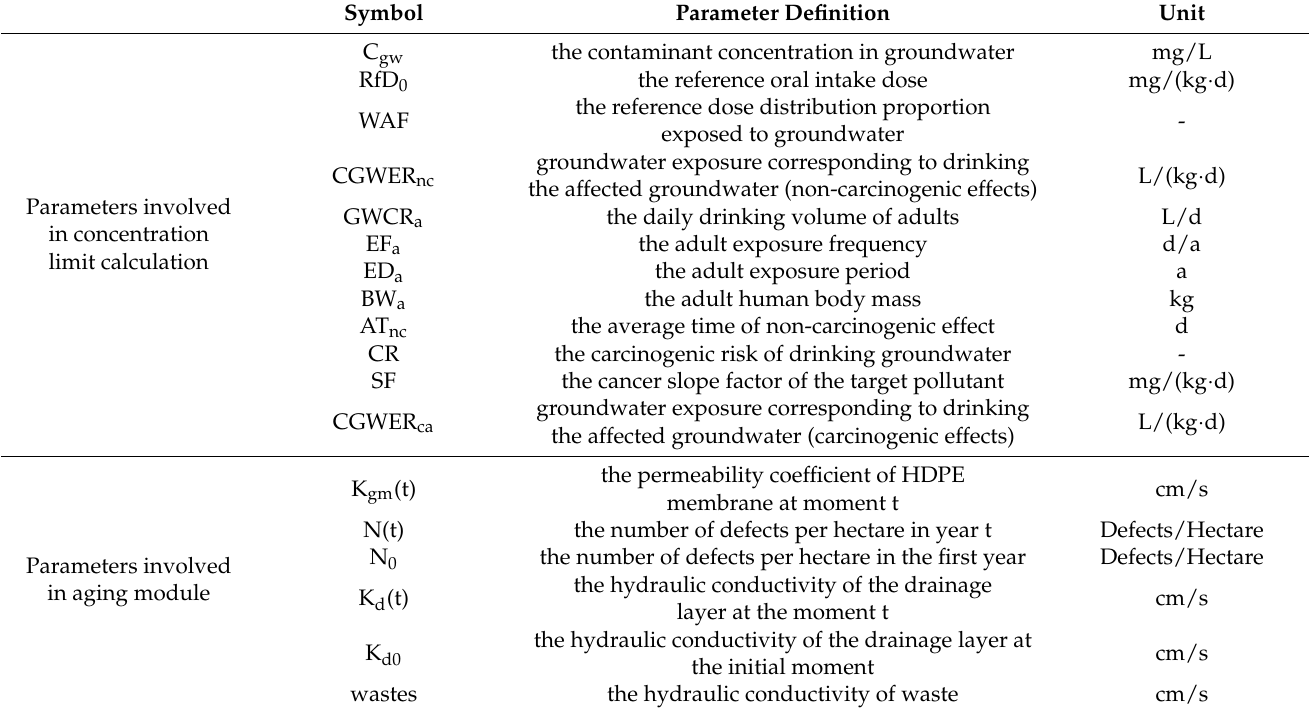
Table 1. Parameters involved in concentration limit calculation and aging